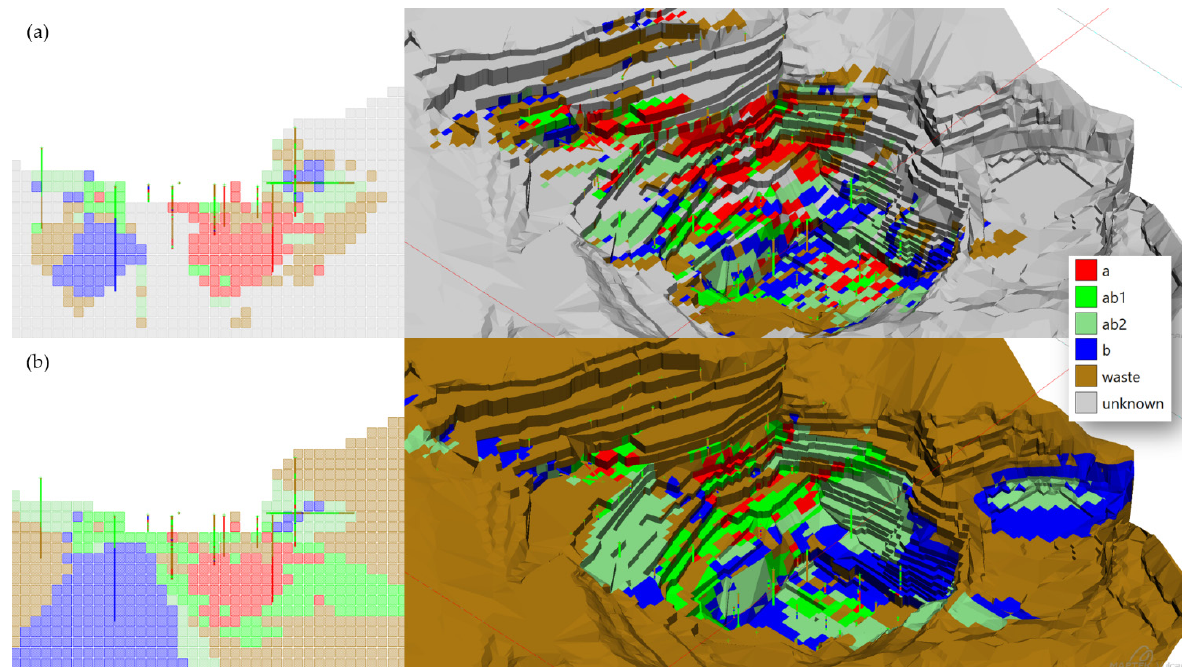
Figure 4. Cross section (left) and 3D view (right) of conventional method ( a ), and DomainMCF predictions ( b ). ID2 estimates were limited by a search ellipsoid while DomainMCF was free to estimate the entire block model.